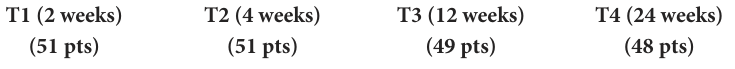
TABLE 1 Patients baseline